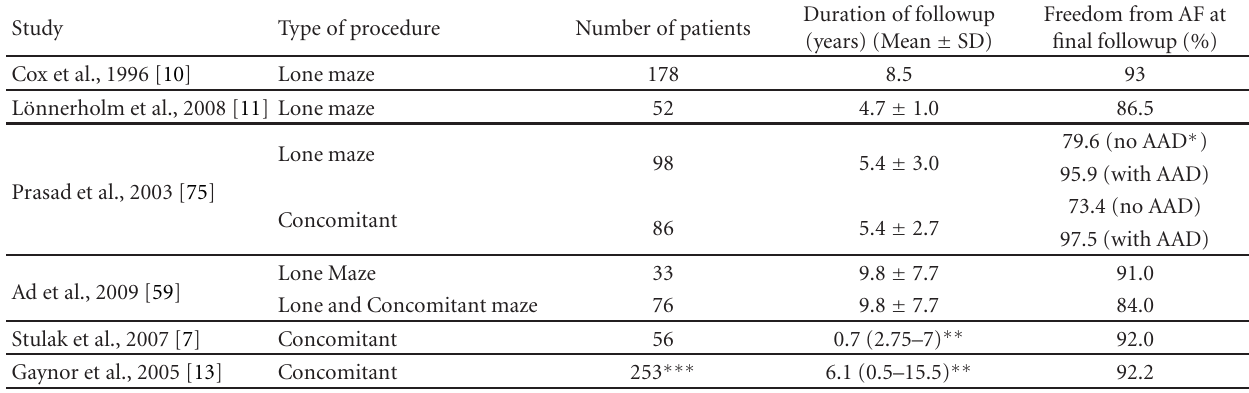
Table 1: Freedom from AF at final follow up after “cut and sew” maze procedure.